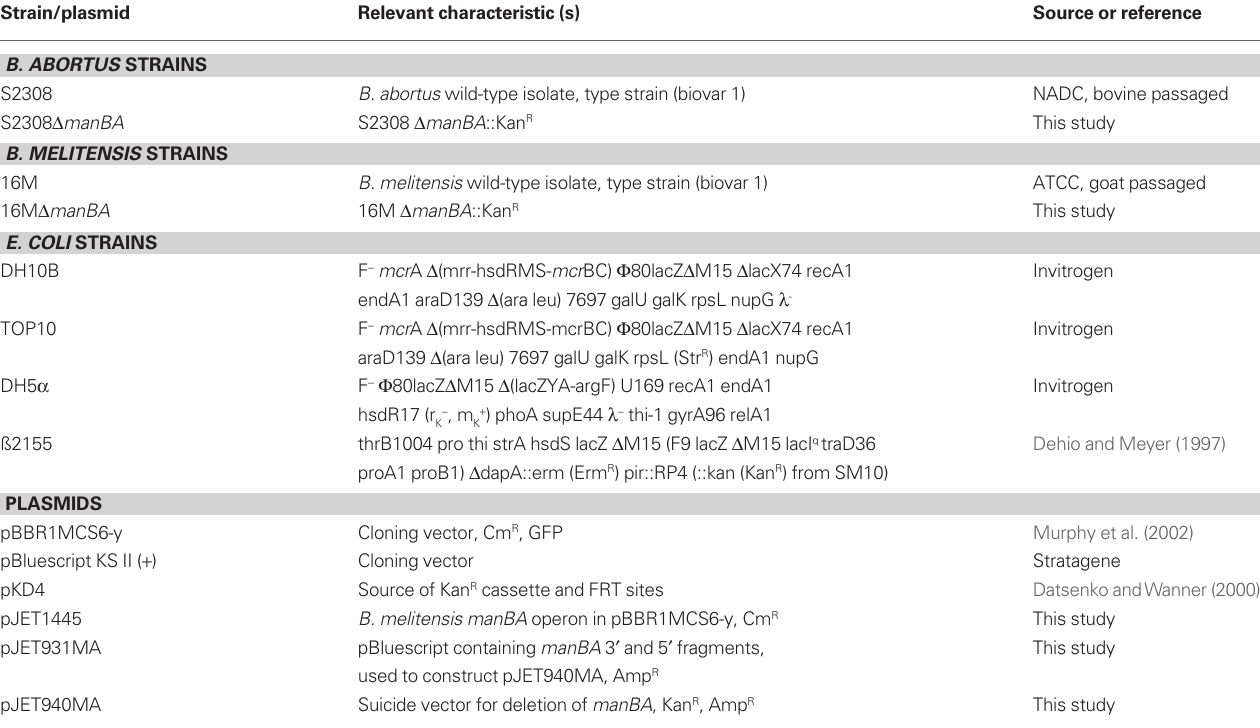
Table 1 | List of strains and